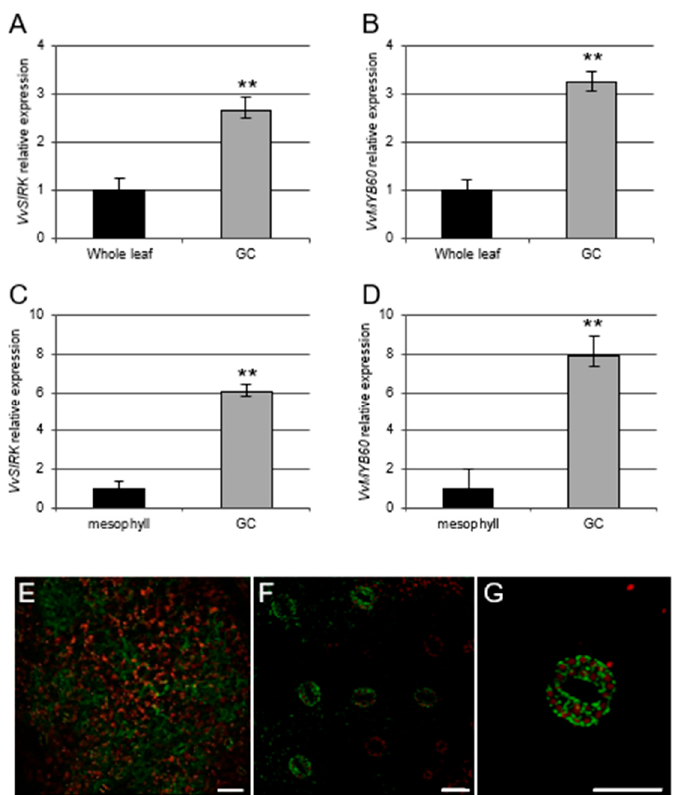
Figure 1. VvMYB60 is preferentially expressed in guard cells. ( A , B ) qPCR analysis of VvSIRK ( A ) and VvMYB60 ( B ) expression in epidermal fragments enriched in intact guard cells and in whole leaves. ( C , D ) Expression of VvSIRK ( C ) and VvMYB60 ( D ) in LM-purified guard cells and mesophyll cells. Gene expression was normalized to the expression of the GLYCERALDEHYDE-3-PHOSATE DEHYDROGENASE ( G3PDH ) gene. Values represent means ± standard errors . Asterisks (**) indicate significant differences at p < 0.01 (ANOVA). ( E – G ) Confocal analysis of grape leaves agro- infiltrated with the 35SCaMV pro :GFP ( E ) or with the VvMYB0 pro :GFP construct ( F , G ). Chlorophyll autofluorescence is shown in red. Scale bars: ( E ), 50 μ m; ( F , G ), 25 μ m.